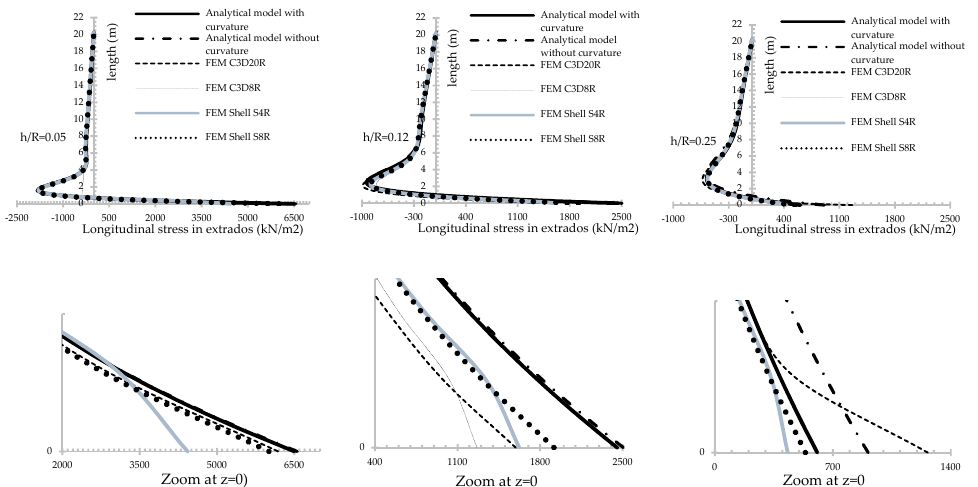
Figure 11. Longitudinal stress in extrados for thin, medium and thick shells, considering different models.